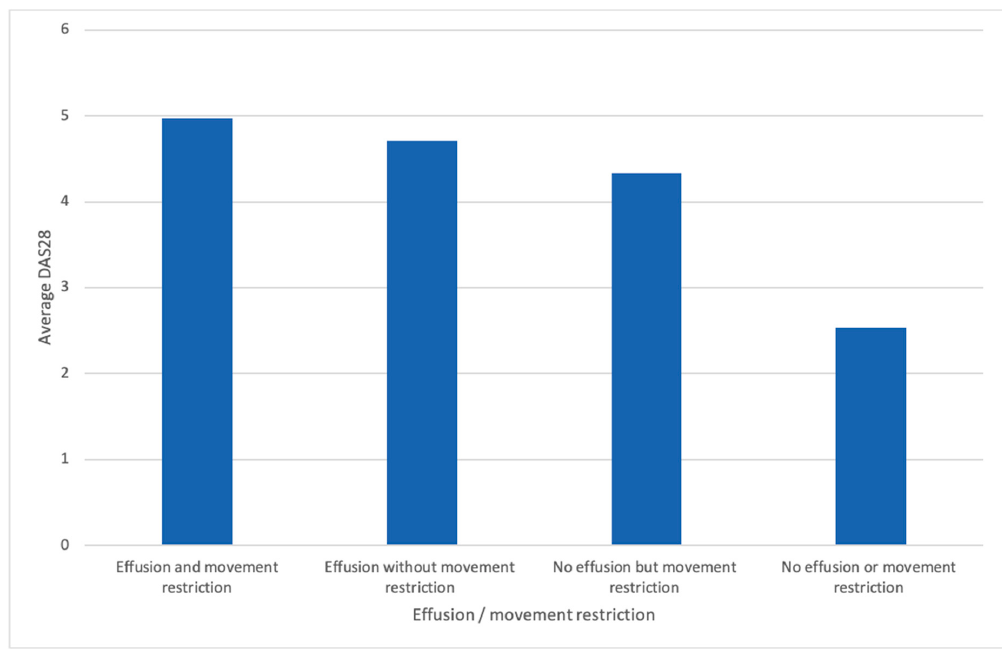
Figure 4. Correlation between the DAS28 and joint effusion/movement restriction . DAS28 = Disease Activity Score in 28 joints.